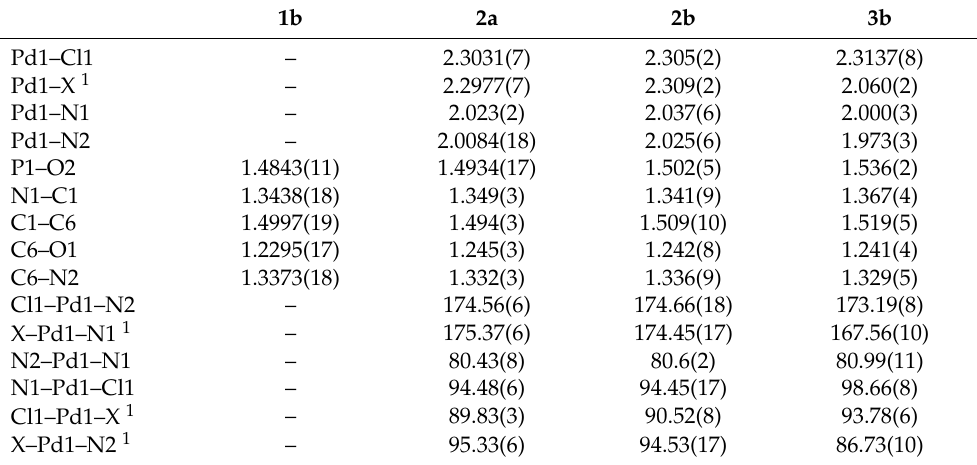
Figure 3. Molecular structures of complexes 2a ( a ), 2b ( b ), and 3b ( c ). The solvate chloroform molecule in 2b is omitted for clarity. Dotted lines stand for hydrogen bonds. Table 1. Selected bond lengths (Å) and angles (°) for compounds 1b , 2a , b , and 3b .